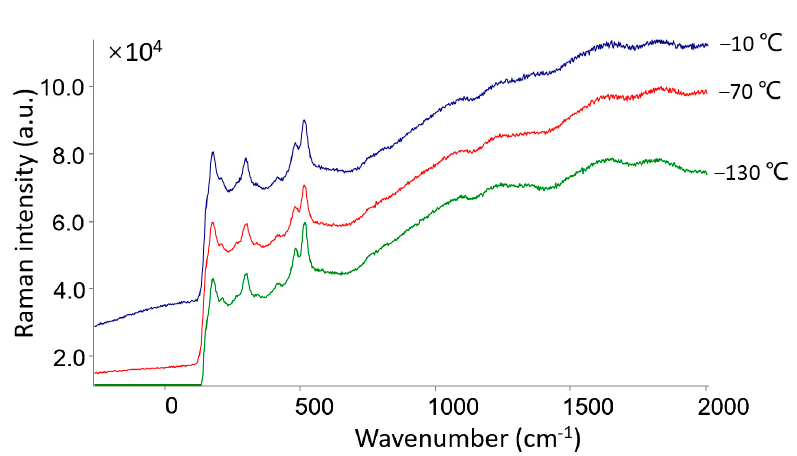
Figure 5. Raman spectra of feldspar under low temperatures ( − 10, − 70, and − 130 °C) at 30 Pa.